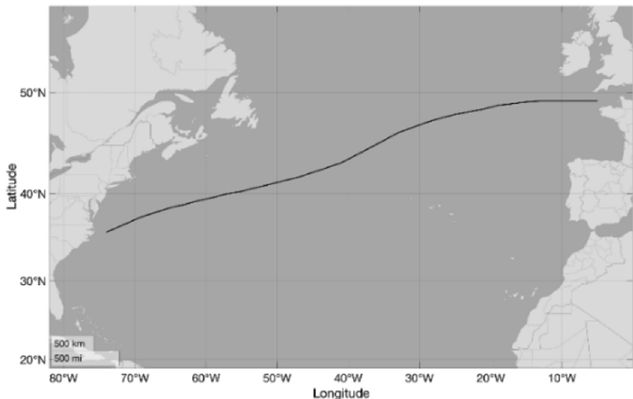
Figure 5. Northern route from the British Channel to the east coast of the US [58].